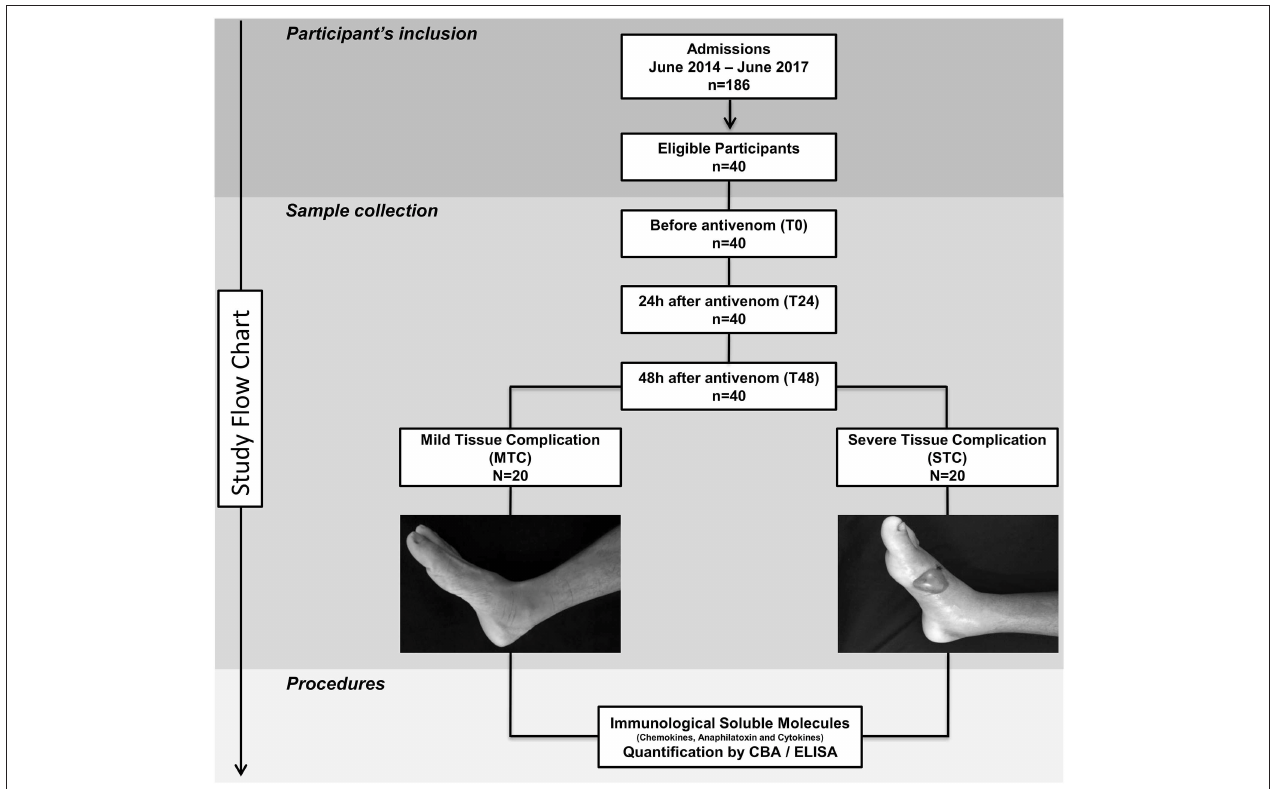
FIGURE 1 | Flowchart of study. Forty patients were eligible and followed up until discharge. These patients were divided into two groups: Mild Tissue Complication (MTC) and Severe Tissue Complication (STC), according to their clinical outcome. STC patients developed a blister and had transudate collected 48h after antivenom